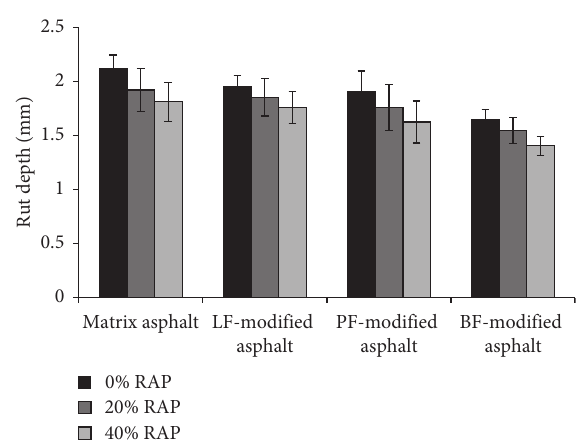
Figure 6: Flexural strain results of different asphalt